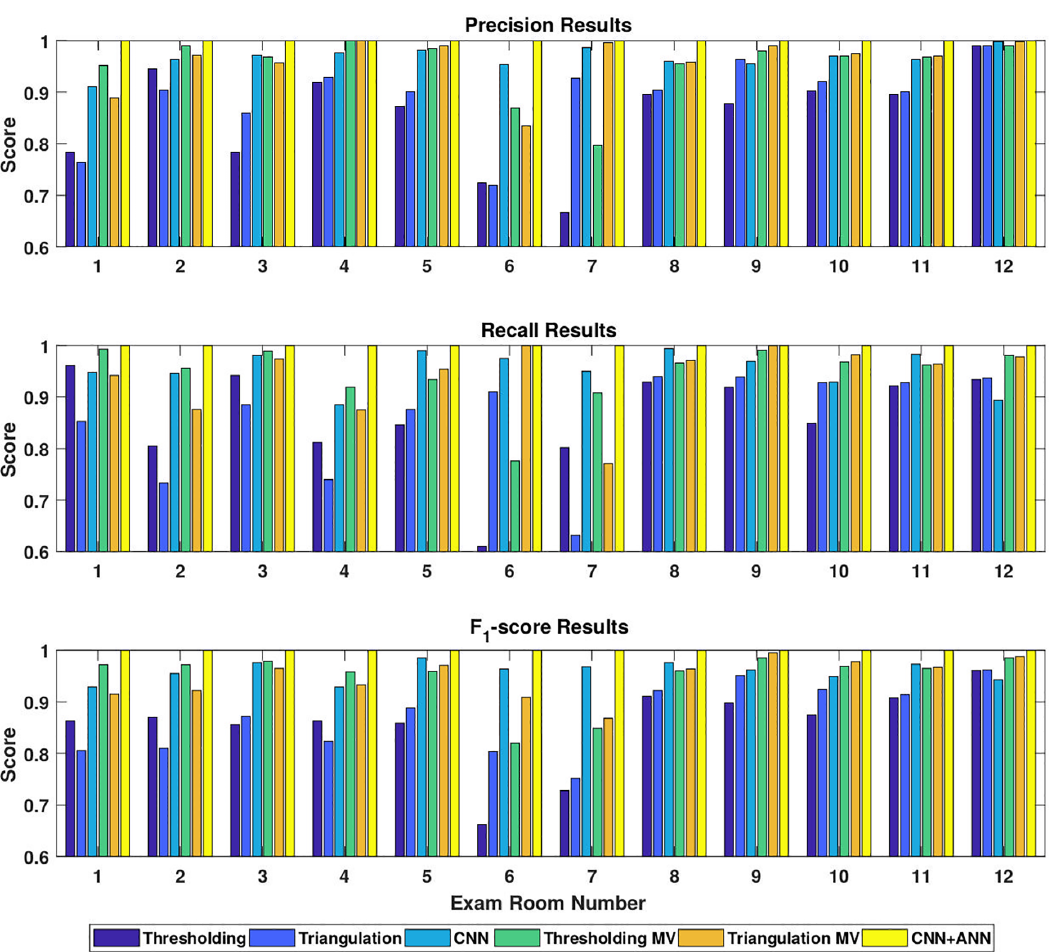
Fig 6. Bar graph of classification results. Precision, recall, and F 1 -score results using the four classification methods (Thresholding, Thresholding with majority voting, CNN, and CNN+ANN) are shown.